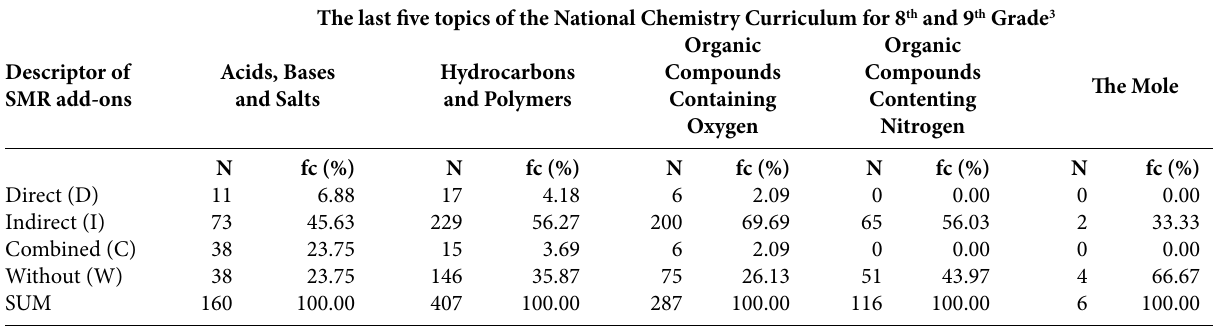
Table 5. The proportion of SMRs within the particular topics of the textbook sets – part